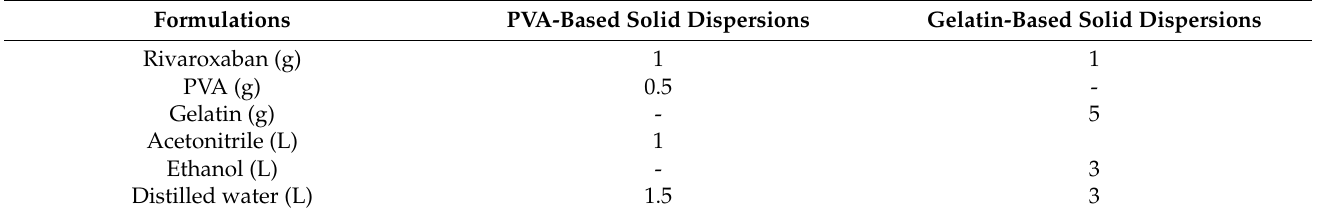
Table 1. Composition of rivaroxaban (RXB)-loaded solid dispersions.